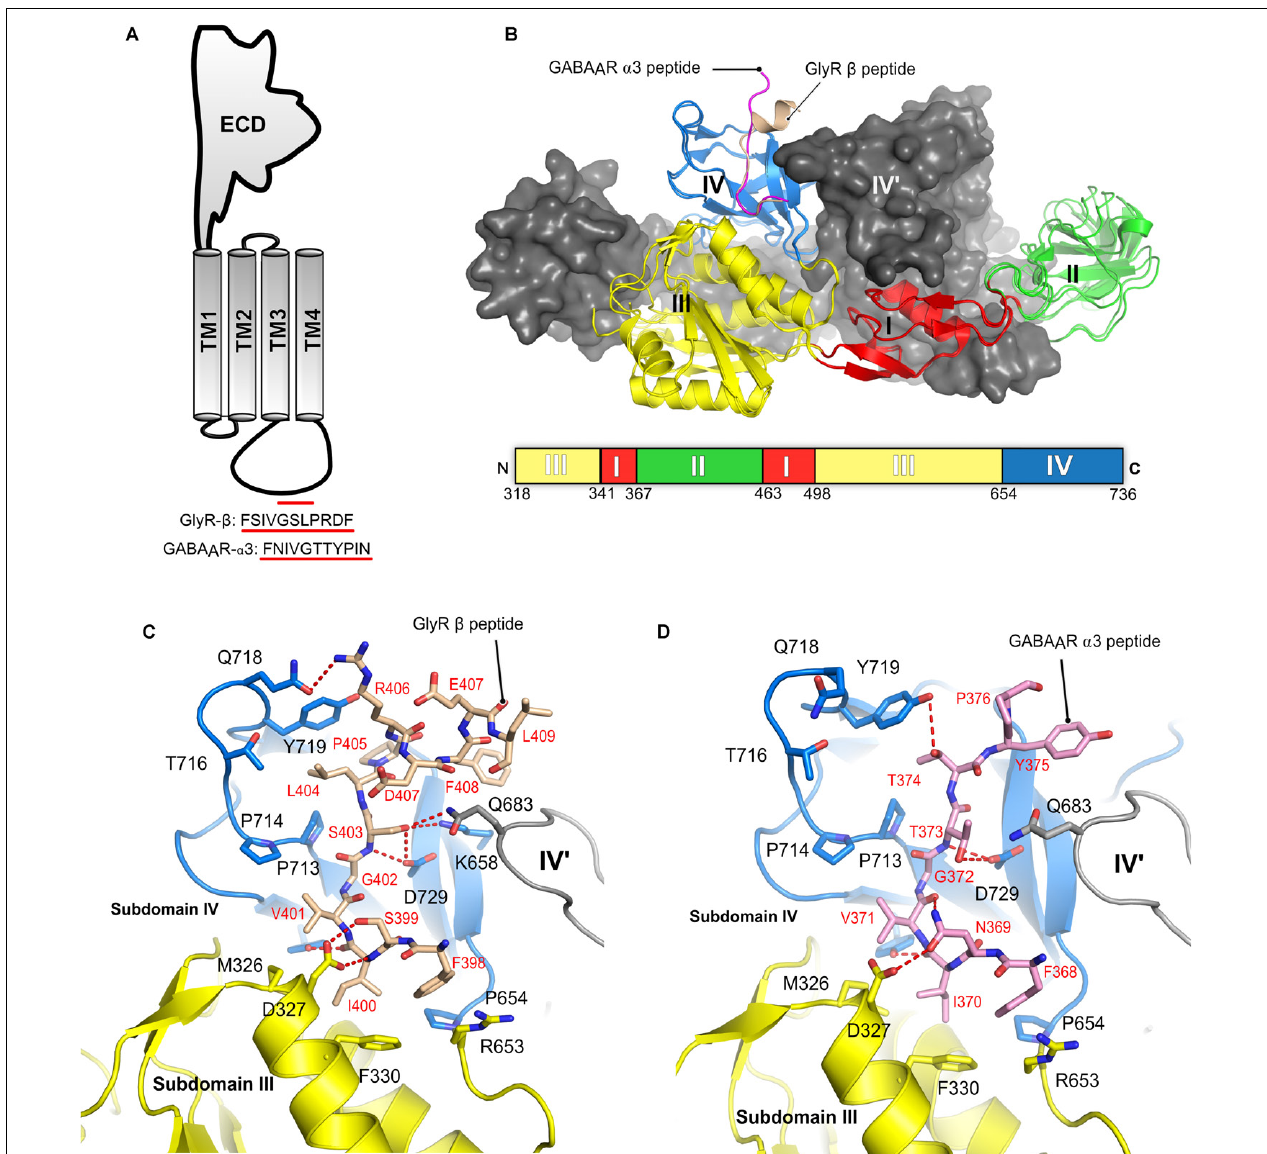
FIGURE 7 | Structures of the gephyrin-receptor interactions. (A) Schematic representation of a single subunit of an inhibitory GABA A R or GlyR. The core binding motifs mediating the interaction of the receptor with gephyrin are underlined in red. (B) Overall architecture of the superimposed crystal structure of GephE in complex with the GlyR- β 49 (PDB:2FTS) and GephE-GABA A R α 3 11 peptide (PDB: 4TK1), where the GephE subdomains are colored according to the scheme shown below the superimposed structure and are labeled with Roman numerals. Close-up view of the interaction of GlyR β 49 ( C , shown as light brown sticks) and GABA A R α 3 ( D , light pink sticks) with GephE. The receptor counterpart and residues of GephE, which are crucial for binding, are shown in stick representation and the others as a cartoon model. Please note that Asp327 of the E domain effectively interacts with the GlyR peptide forming both side chain-side chain and side chain-main chain interactions in contrast to the GABA A R α 3 peptide and also the favorable interaction of Leu404 of the GlyR peptide in contrast to the partially polar Thr374 of GABA A R α 3. These interaction primarily determine the different receptor affinities for